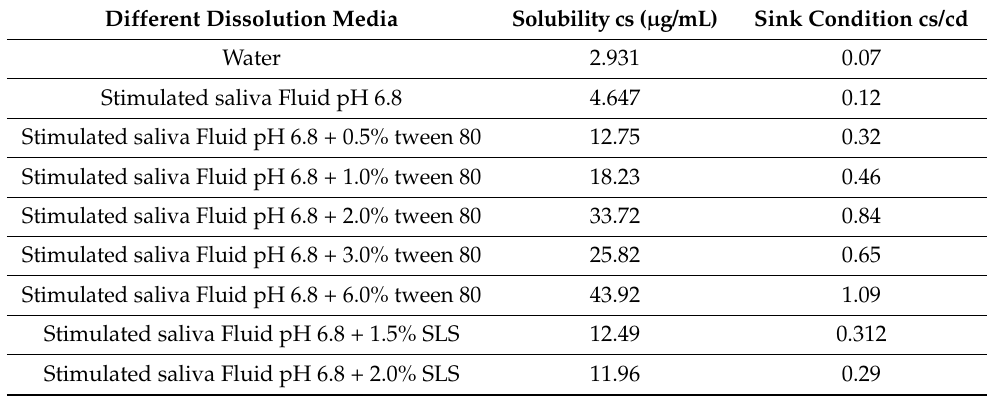
Table 2. Solubility (cs) and relative sink conditions (cs/cd) of telmisartan at different dissolution media & different surfactant concentration on relative sink